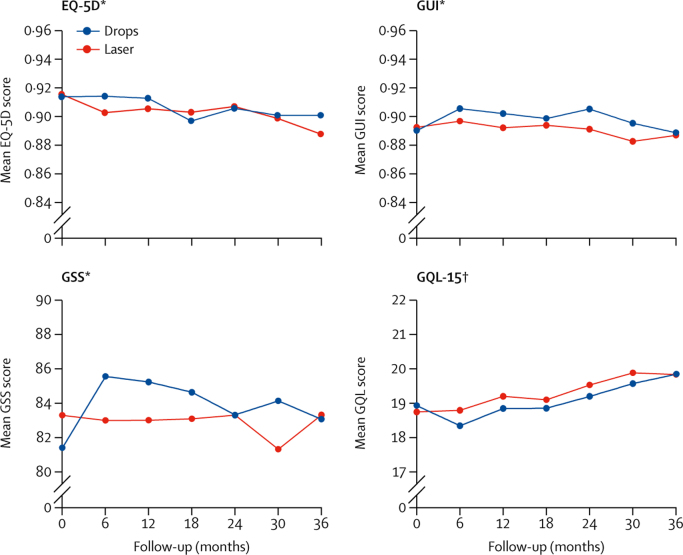
Mean EQ-5D, GUI, GSS, and GQL-15 scores at each time point, across 36 monthsTime-point ‘0’ refers to pre-treatment. EQ-5D=EuroQol 5 Dimensions 5 Levels. GUI=Glaucoma Utility Index. GSS=Glaucoma Symptom Scale. GQL-15=Glaucoma Quality of Life-15. *Higher scores indicate better health-related quality of life. †Higher scores indicate worse health-related quality of life.